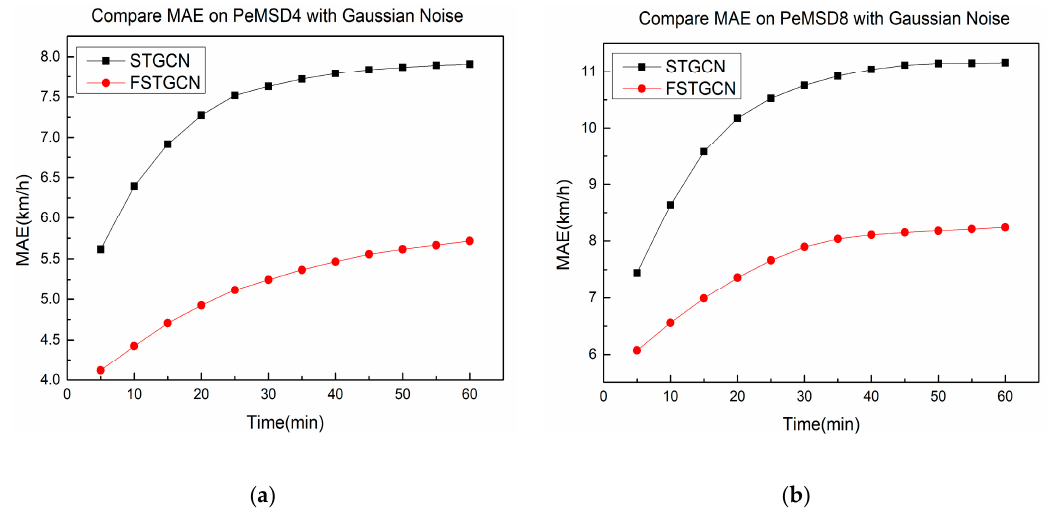
Figure 6. Further comparison on test sets with Gaussian noise. ( a ) PeMSD4. ( b ) PeMSD8.